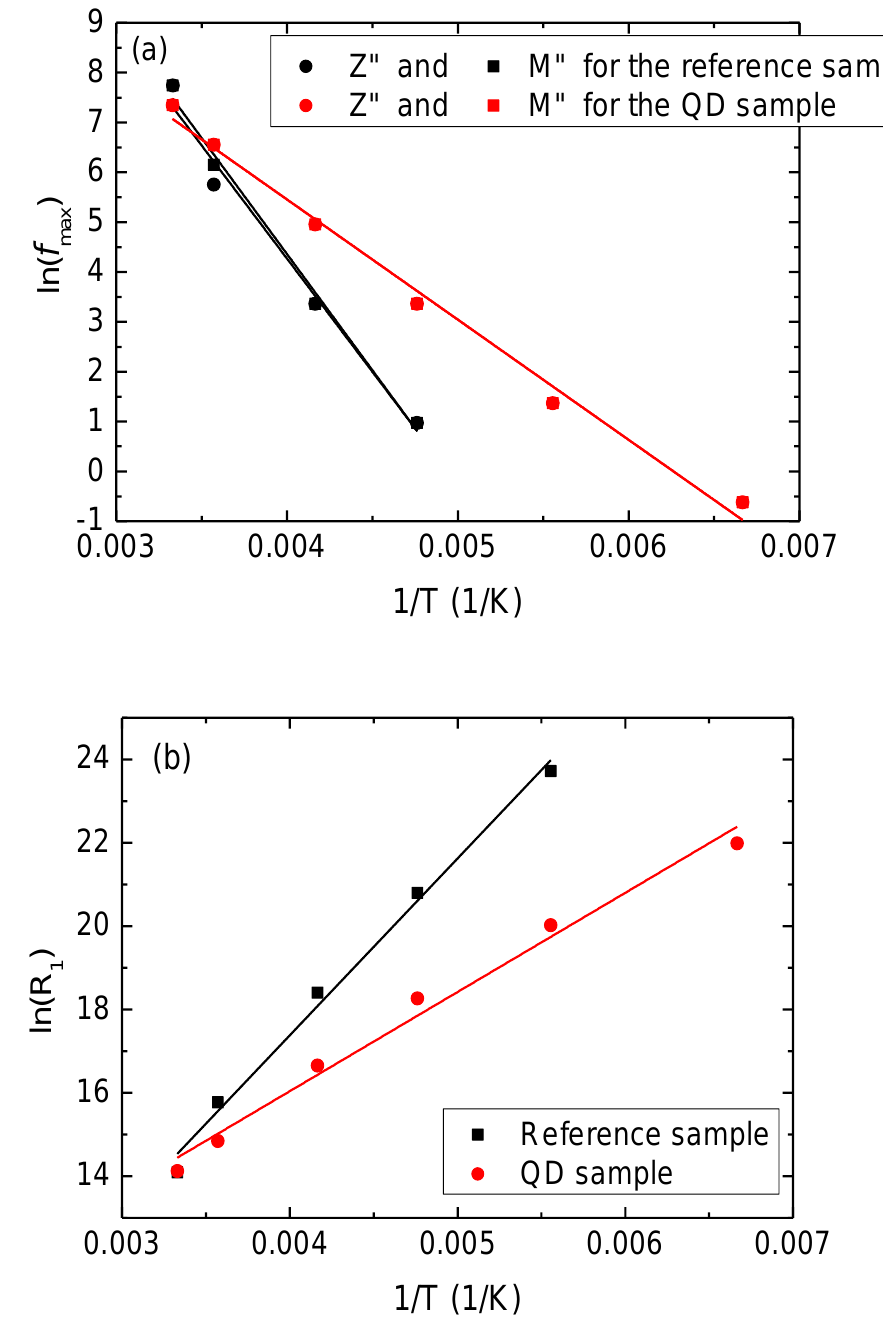
Figure 8. Arrhenius plots of ln(f max ) vs. 1 / T ( a ) and ln(R 1 ) vs. 1 / T ( b ) for the reference and quantum dot samples.